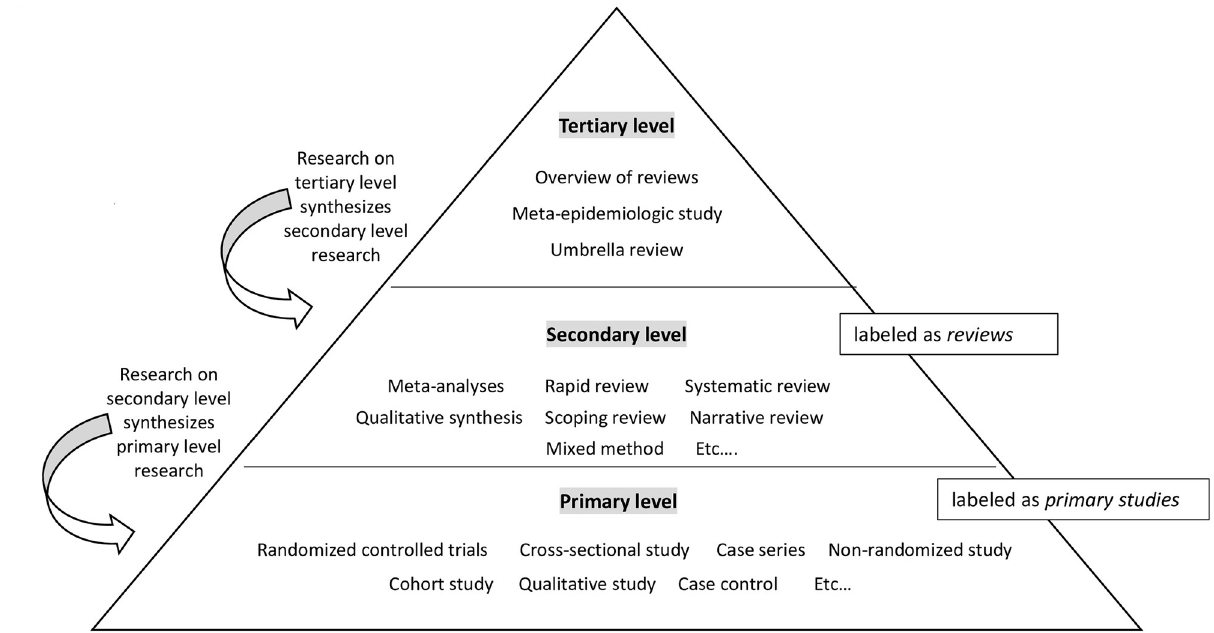
Fig 1. Hierarchy of research levels. Notes . On tertiary level (e.g., overview of reviews) we synthesize studies on secondary level. On secondary level (e.g., meta-analysis) synthesize studies on primary